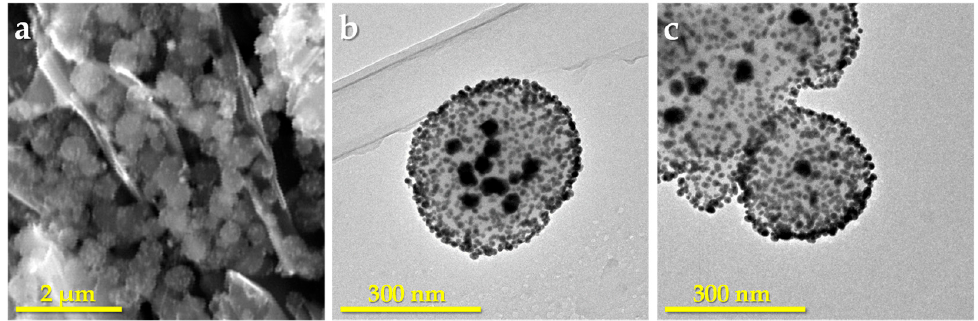
Figure 2. ( a ) SEM microphotograph of Au-PDA spheres of 470 nm on a graphite surface; ( b ) and ( c ) TEM micrographs of Au-PDA spheres of 470 nm and 150 nm, respectively. The shape and size of AuNPs have also been related with the organic reductor used to obtain them [57,58]. In fact, it was observed that when glucose, sucrose, and fructose are used as reductors for the synthesis of AuNPs, the strongest reductors, such as glucose or sucrose, generate particles too small for colloidal stability and therefore tend to coales- cence, producing NPs of variable size. However, fructose allows the obtaining of uniform larger NPs [59]. In our case, a 1 mM chloroaurate solution was used, and the obtained AuNPs anchored to the surface of the PDA spheres were about 7 nm in diameter when ascorbic acid was used as the reductor agent. According to the above, the presence of the additional reductor agent, such as ascorbic acid, prevents the agglomeration of the AuNPs and, therefore, the nanoparticles formed on the surface are small despite the high concen- tration of HAuCl 4 . On the other hand, the 30–35 nm AuNPs observed within the PDA nanospheres must be attributed to the diffusion of chloroauric acid in the core of the PDA nanosphere, which cannot be accessed by ascorbic acid, probably by steric hindrance. The fact that these internal particles are the same size and one or more are formed depending on the size of the sphere can be attributed to the hollows of the structure of each PDA sphere and the distribution of the functional groups within them. In our opinion, the discovery of the existence of these isolated nanoparticles within the PDA nanospheres could expand the field of applications of these composites due to the possibility of controlling their quantity and size, which requires knowledge of the in- ternal structures of nanospheres. Taking into account the above-mentioned observations, extensive molecular dynam- ics simulations were performed. Due to the uncertainty regarding the chemical motif of PDA, four candidates were considered. The morphology displayed by the smaller models in the molecular dynamics’ trajectories with explicit solvent is shown in Figure 3. While the three DHI-based models ( l DHI, TET-1, and TET-2) exhibit a similar morphology, with a rather spherical compact aggregation of molecules, the PYR model presents a clearly different geometry. More specifically, molecules are stacked, and arranged in disordered vermicular groups with a larger degree of dispersion than those observed in the DHI- based models, to form a rather starfish-like distribution. Differences also appear in the dimensions of the particles: for instance, the average radius of gyration for the PYR nan- ospheres is about 6.10 nm, much larger than the values for the other models (3.80 for l DHI, 3.70 for TET-1, and 3.80 for TET-2). In all cases, the three components of the radius of gyration had almost the same values, indicating that the aggregates have a low degree of anisotropy or asphericity.